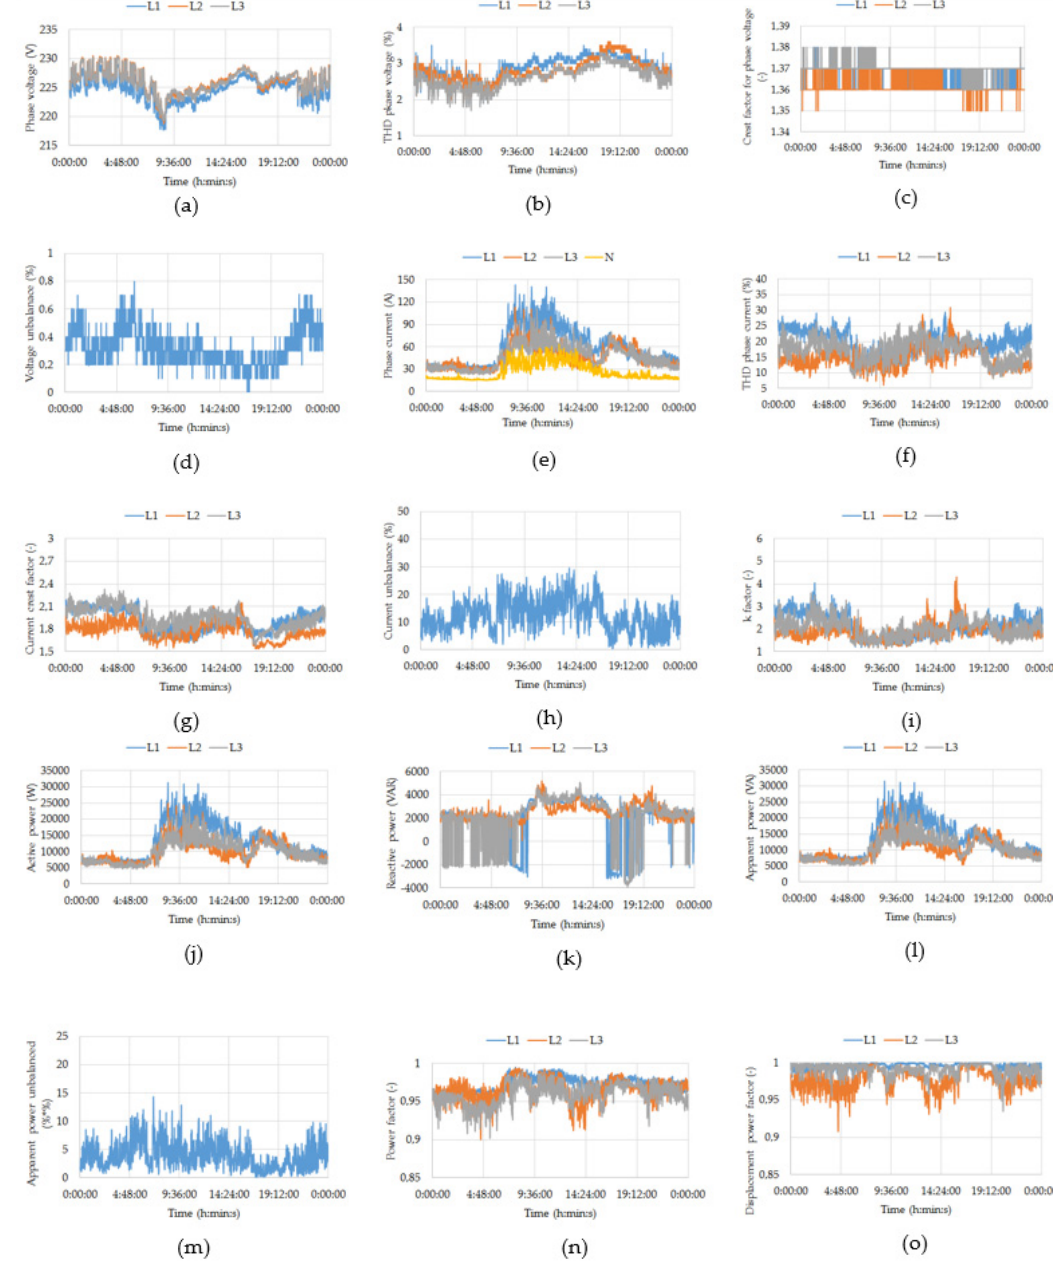
Figure 24. Recordings of some electrical measurement from power substation of residential and educational area in a workday: ( a ) Phase voltages; ( b ) THD for phase voltages; ( c ) Crest factor for voltages; ( d ) Voltage unbalance; ( e ) Phase currents; ( f ) THD for phase currents; ( g ) Crest factor for currents; ( h ) Current unbalance; ( i ) K-factor; ( j ) Active power; ( k ) Reactive power; ( l ) Apparent power; ( m ) Apparent power unbalance; ( n ) Power factor; ( o ) Displacement power factor (for fundamental harmonics).